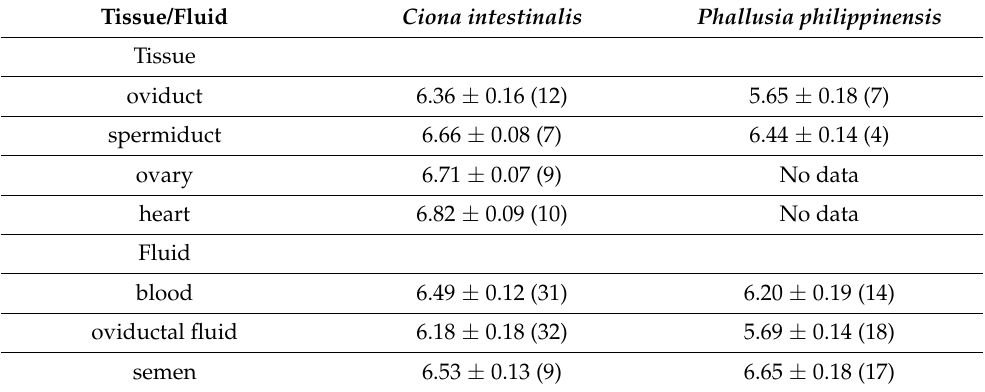
Table 1. Ascidian tissues and fluids: